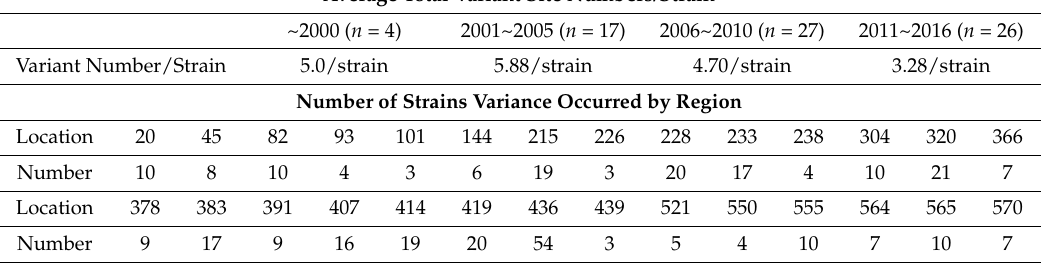
Table 4. Nucleotide substitutions occurred in 28 highly variable regions in the VP2 gene of 74 strains compared to strain Kresse (accession number: U44978.1). The average total variant site number/strain was estimated according to four groups classified into five years. The variance in every region was measured, and the eight most variable regions were